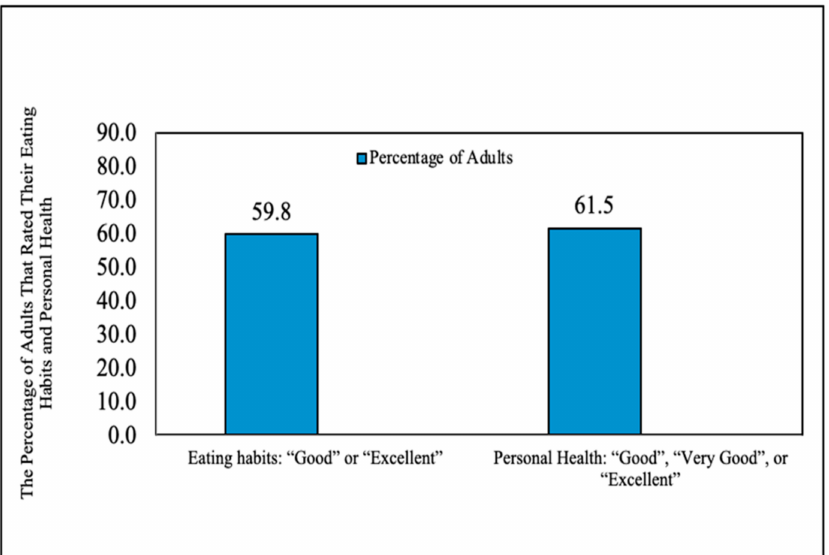
Figure 2. Parents ratings of eating habits and personal